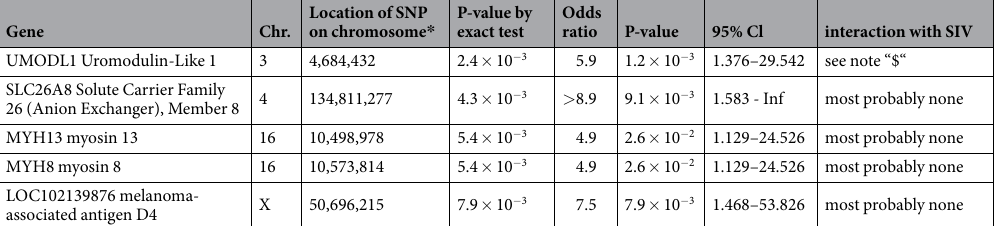
Table 2. Detection of 5 variants that showed strong association with PVL scores (P < 0.01 by means of exact Fisher’s test) in 42 SIV-infected cynomolgus macaques. * The positions are based on the assembly of the Macaca fascicularis genome MacFas5.0 (GCA 000364345.1). $Uromodulin-Like 1 (olfactorin): Knockdown of uromodulin-like 1 (UMODL1) by siRNA inhibits the early stages of HIV-1 replication in 293T cells infected with VSV-G pseudotyped HIV-1.